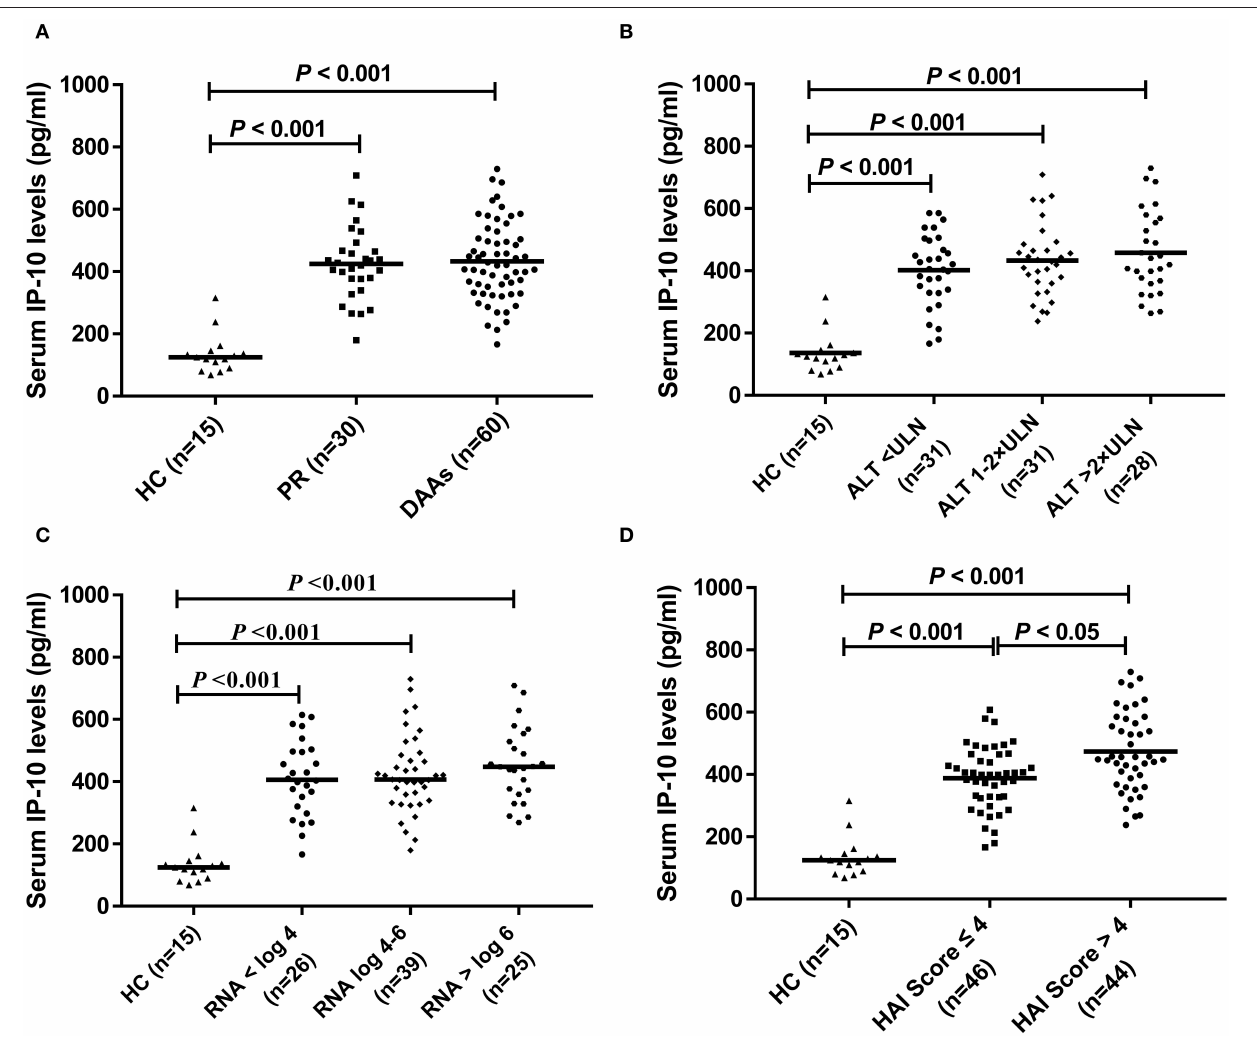
FIGURE 1 | IP-10 levels in serum. (A) Baseline levels of serum IP-10 in HCV-infected patients were higher than that in healthy controls ( p < 0.001), but there was no statistical difference between PR and DAAs treatment group; (B) There was no statistical difference in serum IP-10 levels between different subgroups divided according to ALT levels, although higher than that in healthy controls ( p < 0.001). (C) There was no statistical difference in serum IP-10 levels between different subgroups divided according to HCV RNA loads, although higher than that in healthy controls ( p < 0.001). (D) Regardless of HAI score > 4 or ≤ 4, serum IP-10 levels were both significantly higher than that in healthy controls ( p < 0.001), and it was higher in the group of HAI score > 4 patients than that in ≤ 4 patients ( p <